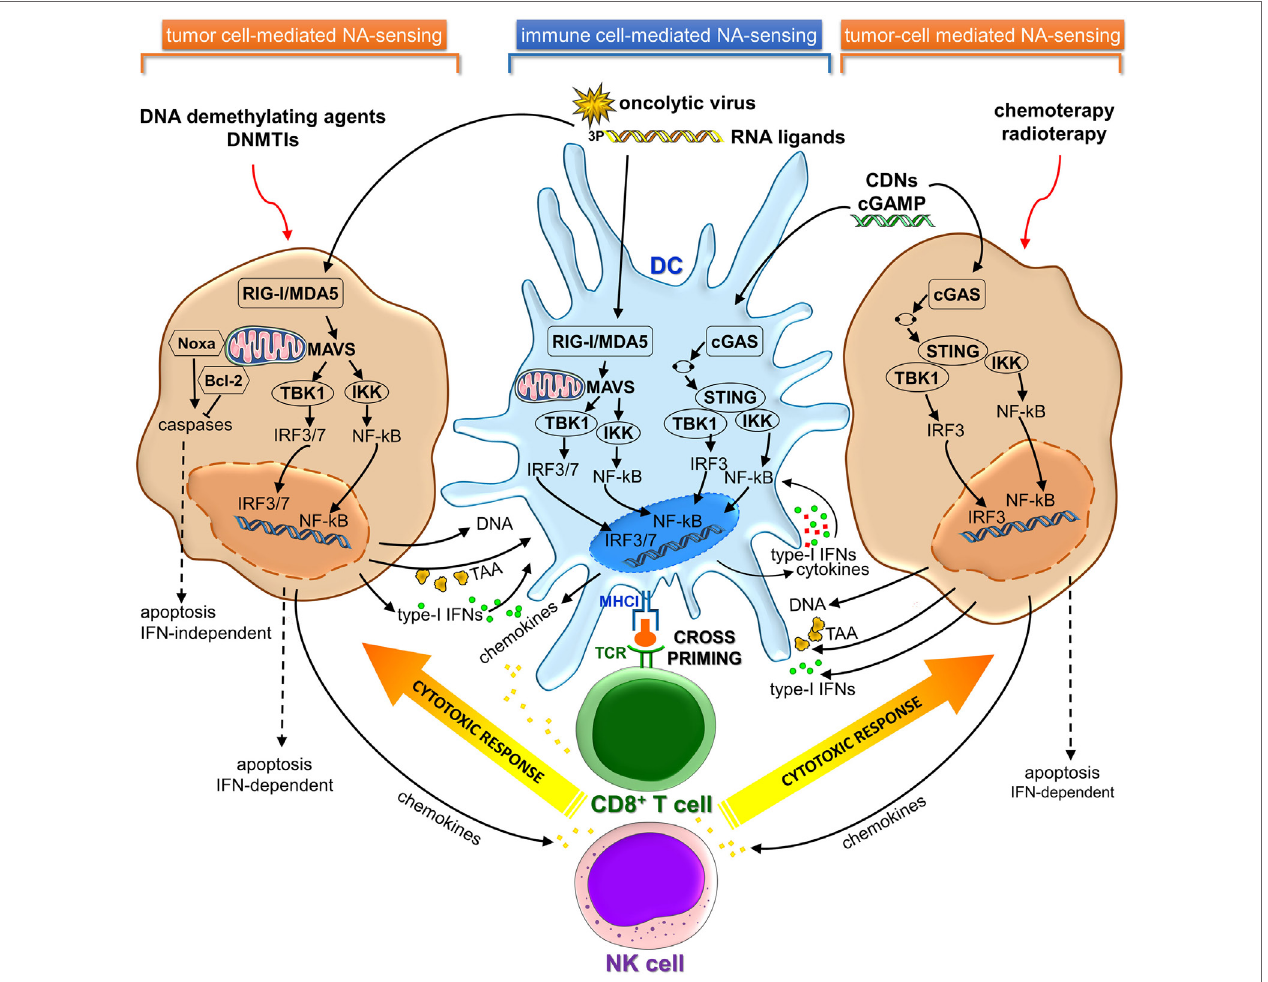
FiGURe 1 | cGAS-STING and RIG-I/MDA5 signaling pathways in immune and cancer cells involved in cancer immunosurveillance and immunotherapy. cGAS, cyclic GMP-AMP synthase; STING, stimulator of interferon genes; RIG-I, retinoic acid-induced gene-I; MDA5, melanoma differentiation-associated gene 5; NA, nucleic acid; TAA, tumor-associated antigen; DNMTIs, DNA methyltransferase